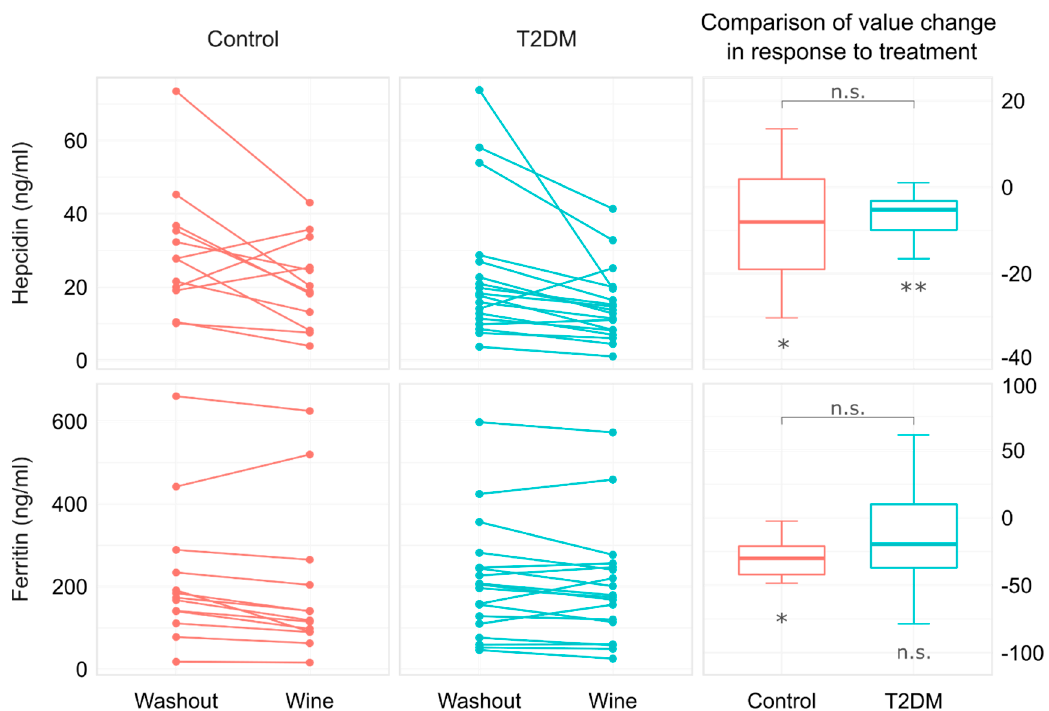
Figure 2. Value changes in hepcidin and ferritin in patients with type 2 diabetes and their age- and BMI-matched controls after 3-week moderate consumption of red wine. The abbreviation n.s. indicates p > 0.05, whilst symbols * and ** indicate p < 0.05 and p < 0.01,